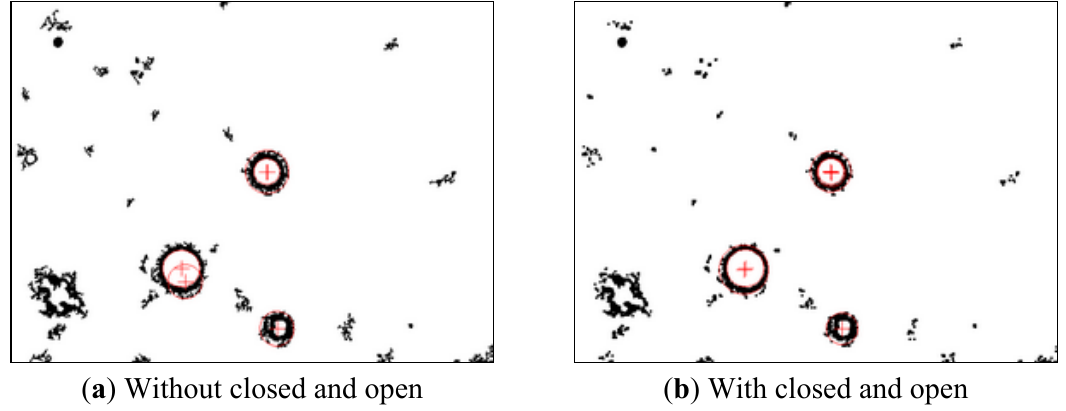
Figure 5. The compared image after closed and open image subVI